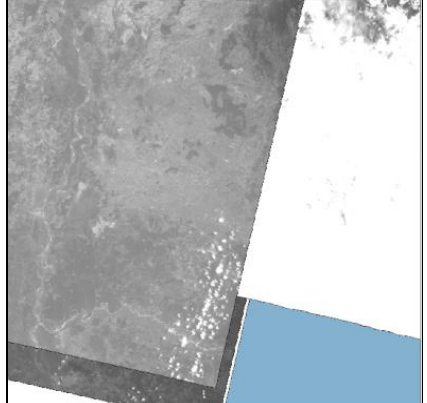
Figure 1 - SPOT 5 HRS coverage over N07W074 Blue and white colours show cloudy areas